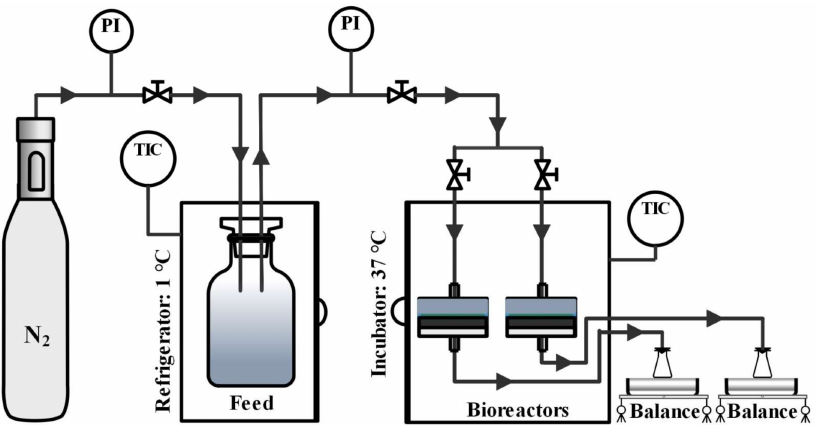
Figure 1. Experimental set-up for anaerobic decolorization of dye molecules by CSCM and CSGOM. Temperature has a significant impact on decolorization performance and microbial population in this compact membrane bioreactor. Thus, the feed solution was kept at 1 ◦ C to prevent microbial growth on the feed tank and maintain its actual dye and co-substrate (Sodium Acetate) composition. After placing 5 mL of secondary anaerobic sludge